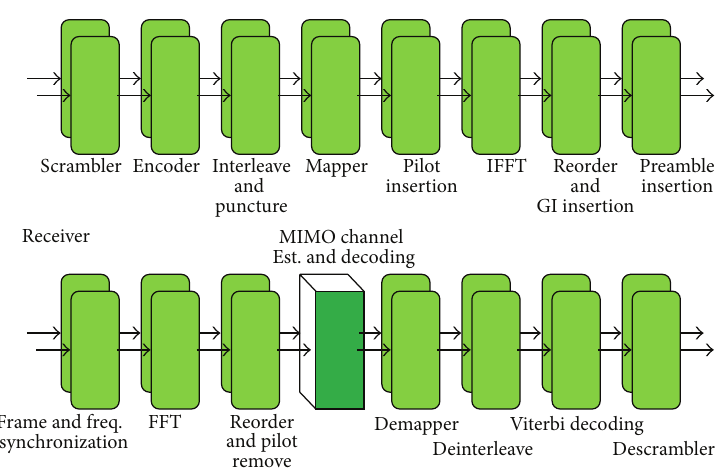
Figure 3: Block diagram of 2 × 2 MIMO-OFDM transmitter and receiver.